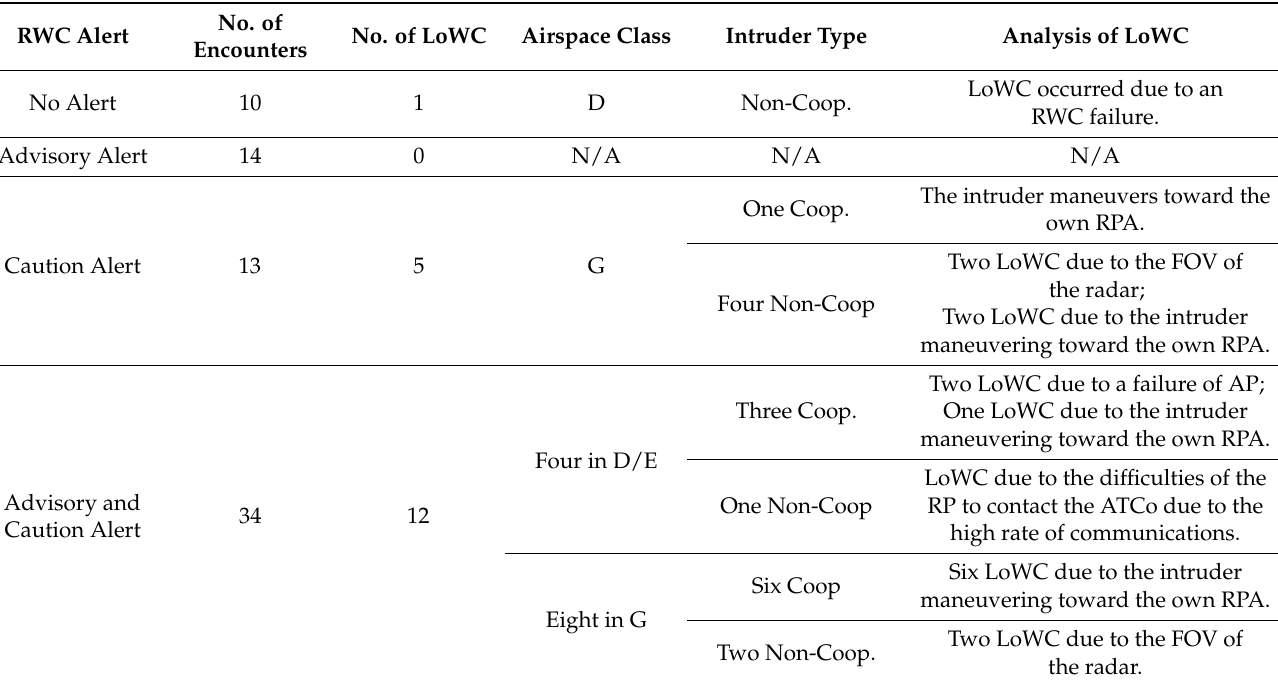
Table 3. Summary of the RT simulations